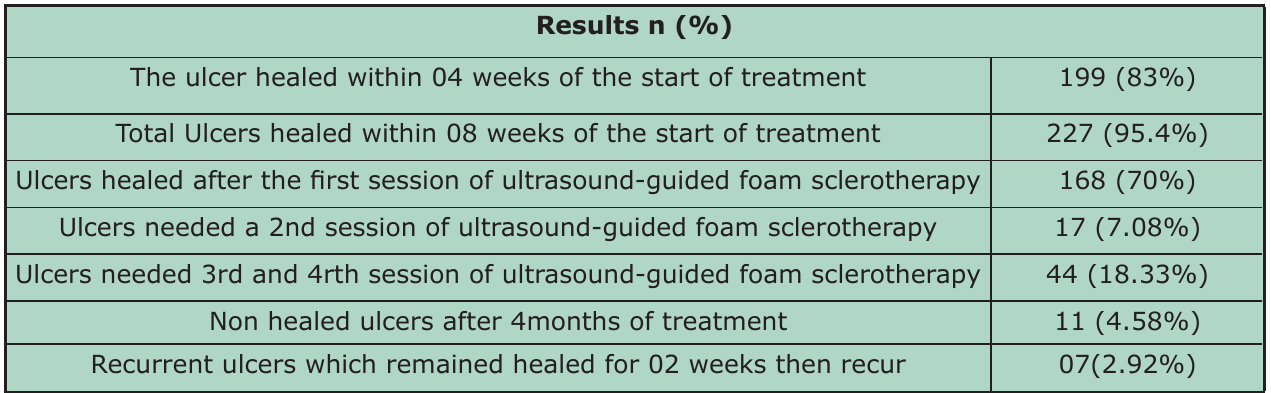
Table-III: Ulcer healing rates and sclerotherapy sessions.